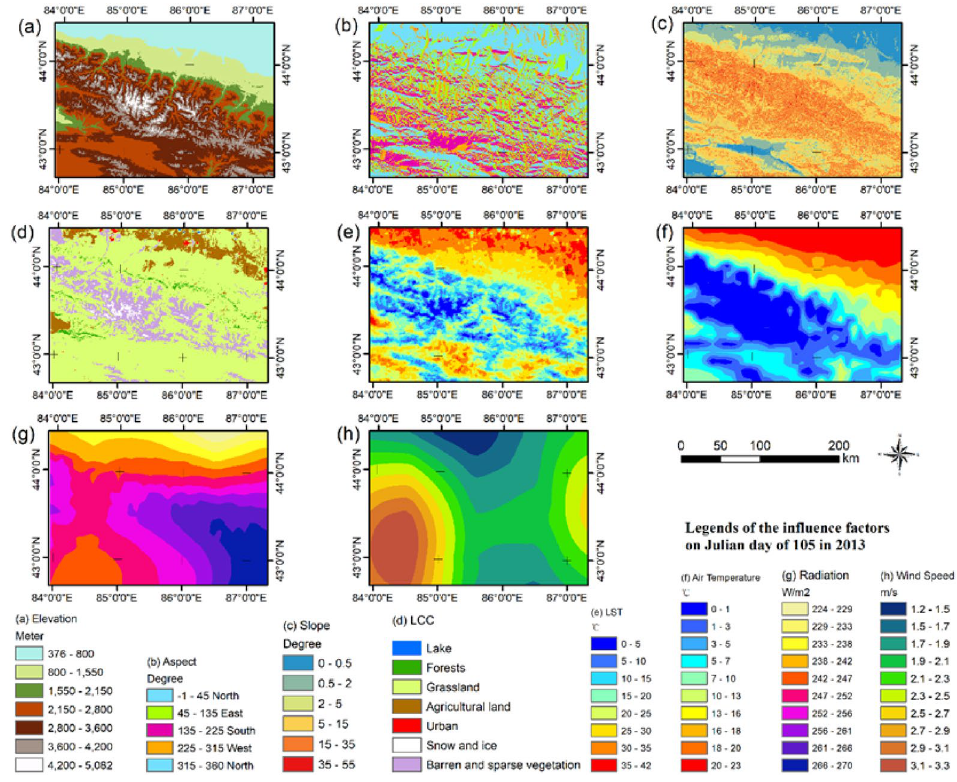
Figure 2. Spatial distributions of all environmental factors in the study area. ( a – c ) are the factors of elevation, aspect and slope calculated by the DEM dataset (https:// www. resdc. cn/ Defau lt. aspx). ( d ) is the factor of Land cover classification (https:// ladsw eb. modaps. eosdis. nasa. gov/). ( e ) is the factor of land surface temperature of the dataset of AWLSTD (https:// data. tpdc. ac. cn/ zh- hans/). ( f – h ) are the factors of air temperature, the shortwave radiation, and the wind speed from the dataset of CMFD. (https:// data. tpdc. ac. cn/ en/ data). Map created in ArcMap 10.6 of the Environmental System Resource Institute, Inc. (https:// www. esri. com/ softw are/ arcgis/ arcgis- for- deskt